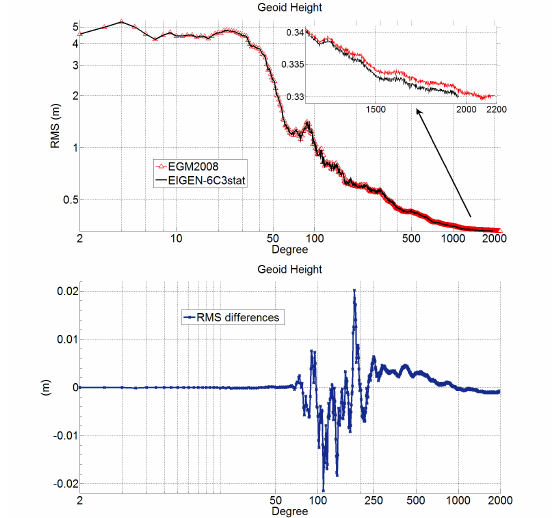
Figure 5: RMS variations in gravity anomaly and geoid height that have been obtained from comparison between terrestrial data and computed values based on the GOCE gravity models by the ESA latest releases. RMS differences at the level of 10 −1 mgal and cm are monitored for the space-wise model over the degree 200.